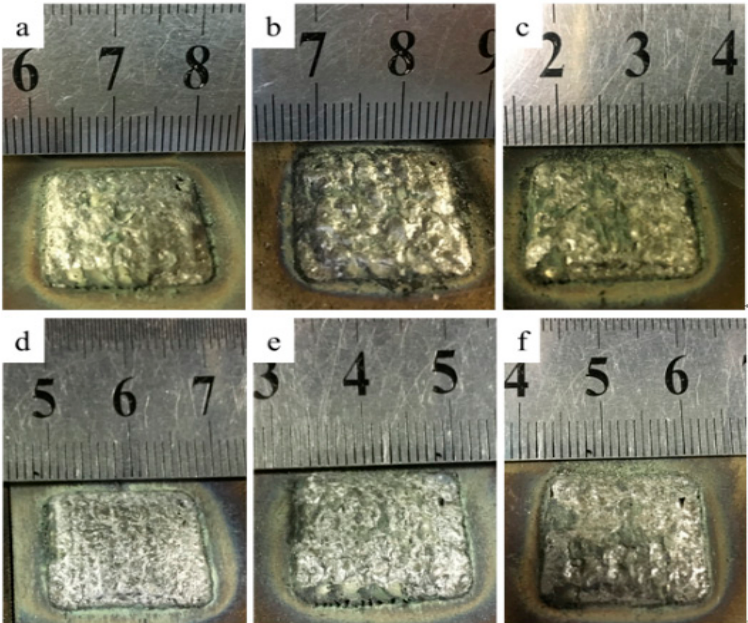
Figure 2. Macro-morphology of NiCrAlY-ZrO 2 composites samples with oxide scale swept off. ( a ) 10% ZrO 2 composites without ultrasonic vibration, ( b ) 20% ZrO 2 composites without ultrasonic vibration, ( c ) 30% ZrO 2 composites without ultrasonic vibration, ( d ) 10% ZrO 2 composites with ultrasonic vibration, ( e ) 20% ZrO 2 composites with ultrasonic vibration, ( f ) 30% ZrO 2 composites with ultrasonic vibration